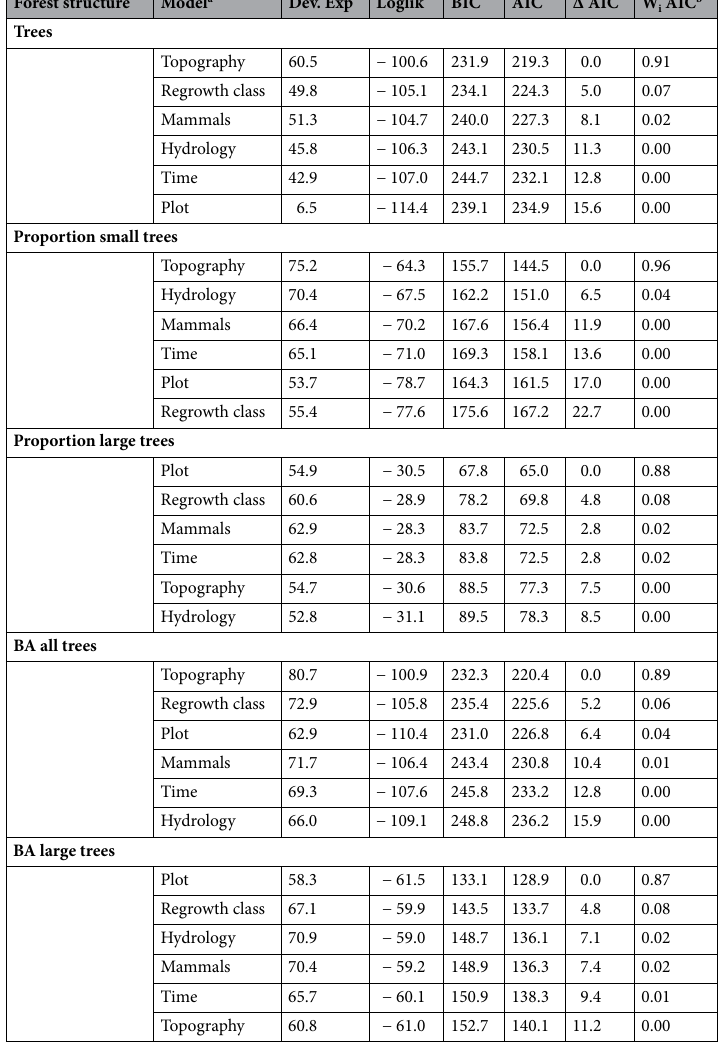
Table 3. Summary of the Generalized Linear Models created to explain forest structure in 30 plots (15 control and 15 regrowth). Models ordered by decreasing AIC (Akaike Information Criterion) values. a Models used to explain forest structure. All models contained plot type (control/regrowth) as categorical factor. Variables and associated estimates in the different models can be found as Supplementary Information Table S2 online. b Akaike weights (W i ) from largest to